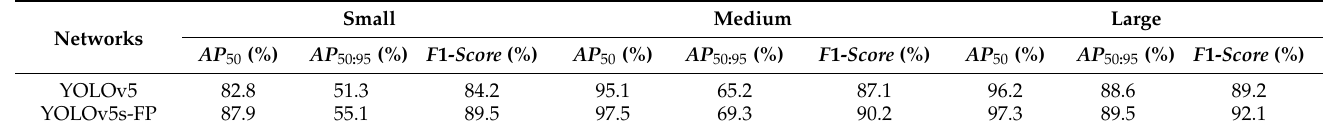
Figure 9. Comparison of pear detection results at different pear sizes, where missing pears were marked in red circles, and pears inside green, blue, and yellow boxes were referred to as large, medium, and small pears, respectively. Table 5. Detection accuracy of two networks at different